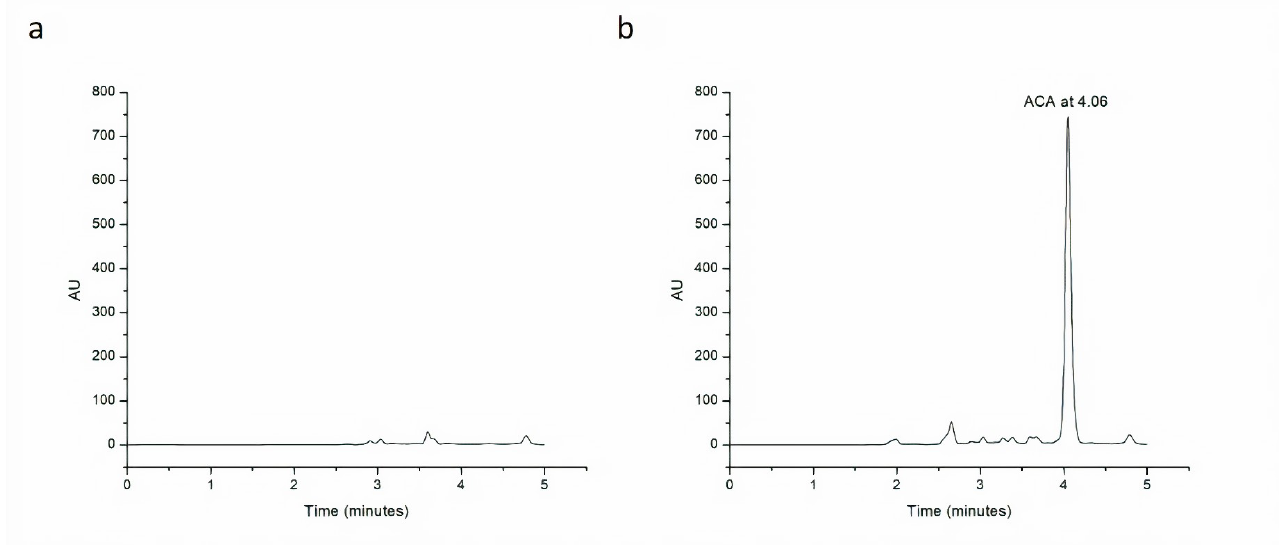
FIGURE 3 - HPLC chromatograms of a) precipitate from blank NLCs and b) precipitate from ACA-NLCs. Conditions: mobile phase acetonitrile:water ratio of 80:20 (v/v), flow rate of 0.8 mL/min, column temperature of 25 °C, sample temperature of 25 °C, and injection volume of 10 µ